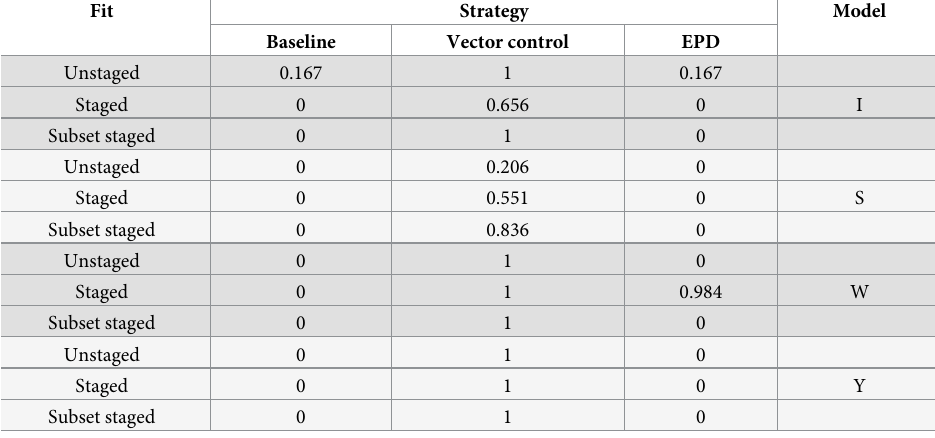
Table 3. Probability of different strategies achieving elimination by